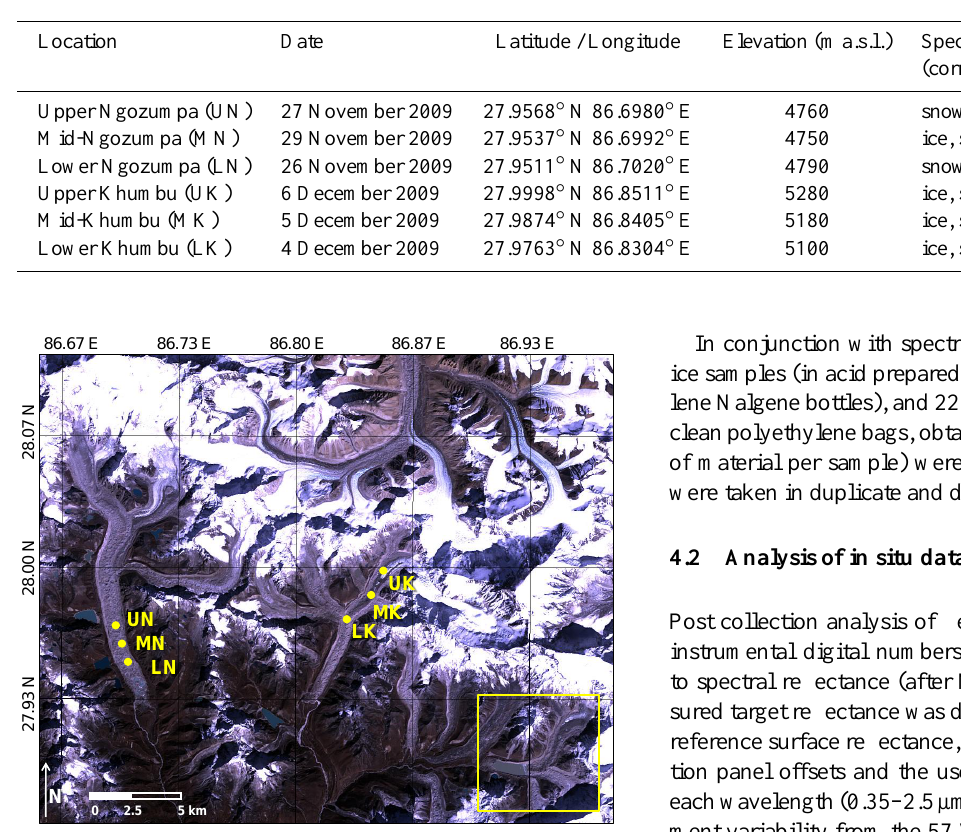
Table 1. Summary of in situ sample attributes, including location, elevation, as well as data collection date, sample type and sample ID. The locations of the field measurement sites are mapped in Fig. 2 and sample ID’s are also referred to in Table 3.